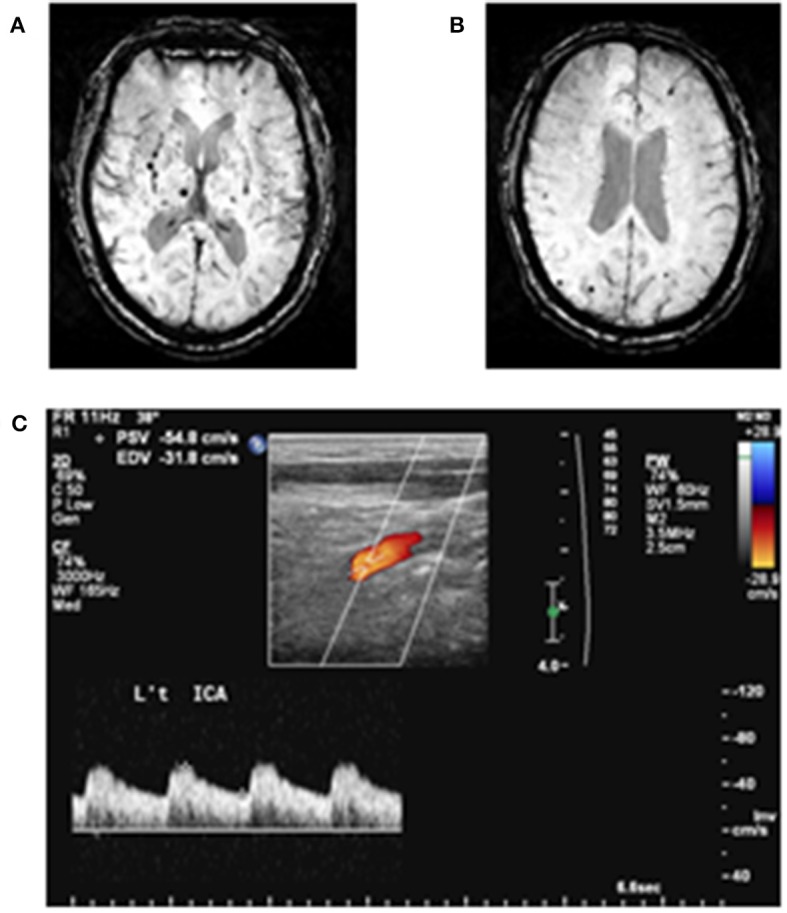
Examples of cerebral microbleeds and arterial pulsatility index measurement. (A) Deep cerebral microbleeds and (B) lobar cerebral microbleeds are demonstrated. (C) Doppler spectrum of internal carotid artery. Arterial pulsatility index is defined as [(peak systolic flow velocity (PSV)—end-diastolic flow velocity (EDV))/mean flow velocity].